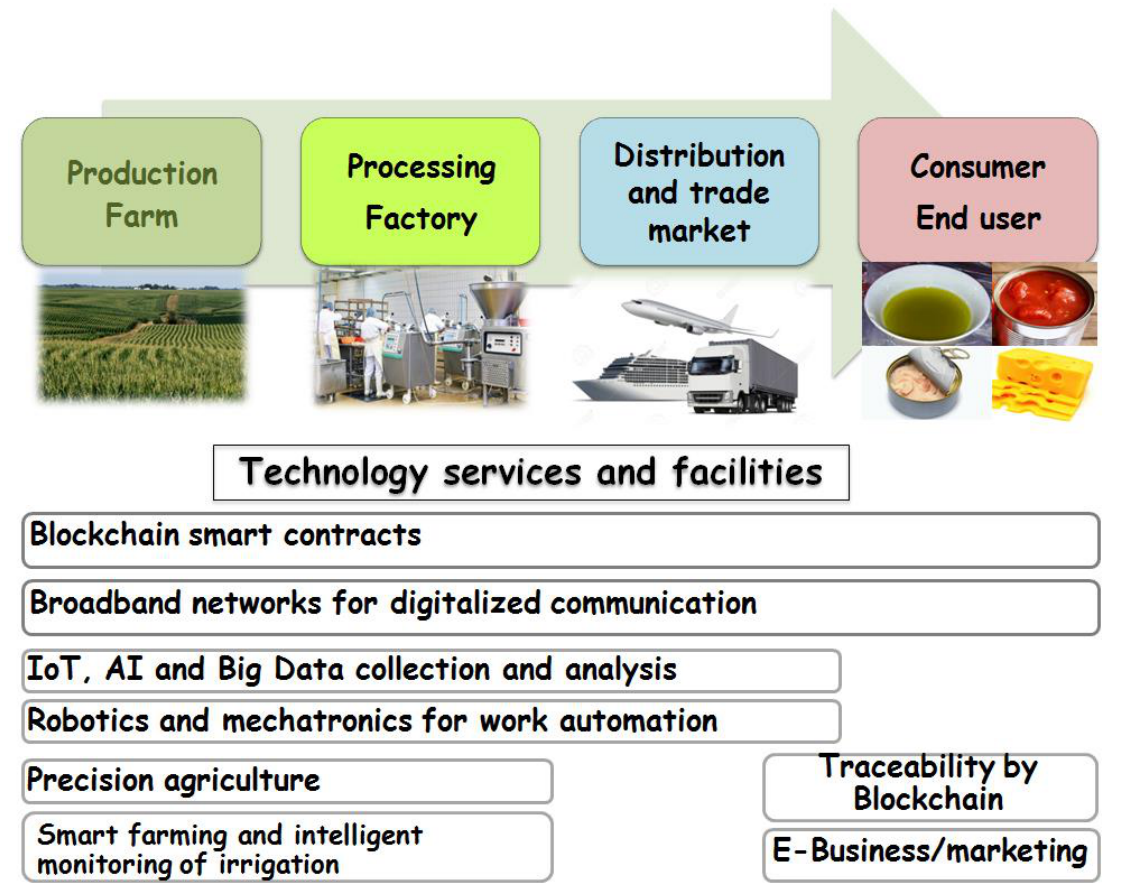
Figure 1. Smart technology integration in agri-food